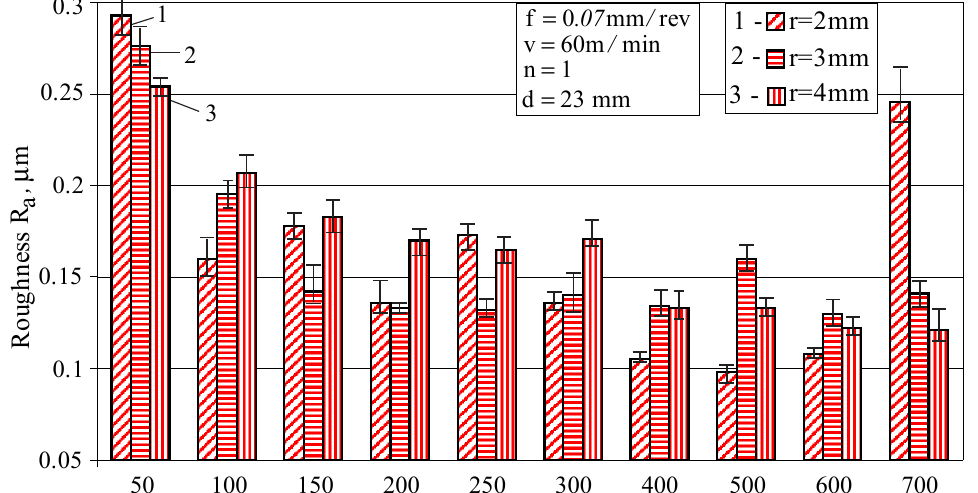
Figure 6. Effect of the radius and burnishing force on the roughness parameter R a .